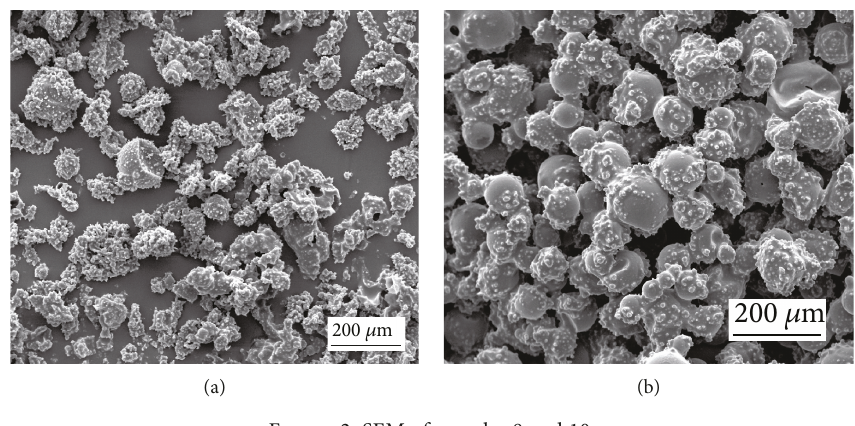
Figure 2: SEM of samples 8 and